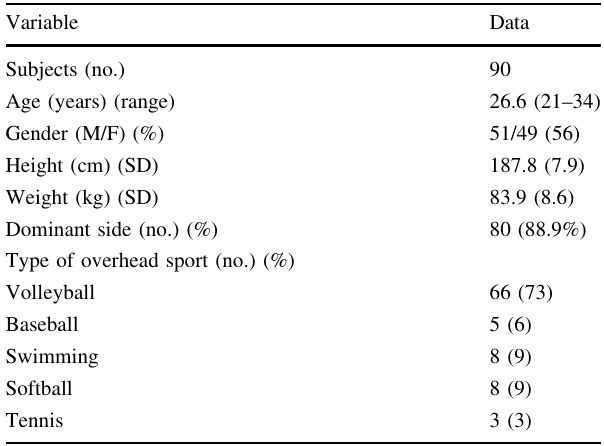
Table 1 Demographics of the 90 overhead athletes participating in the study Variable